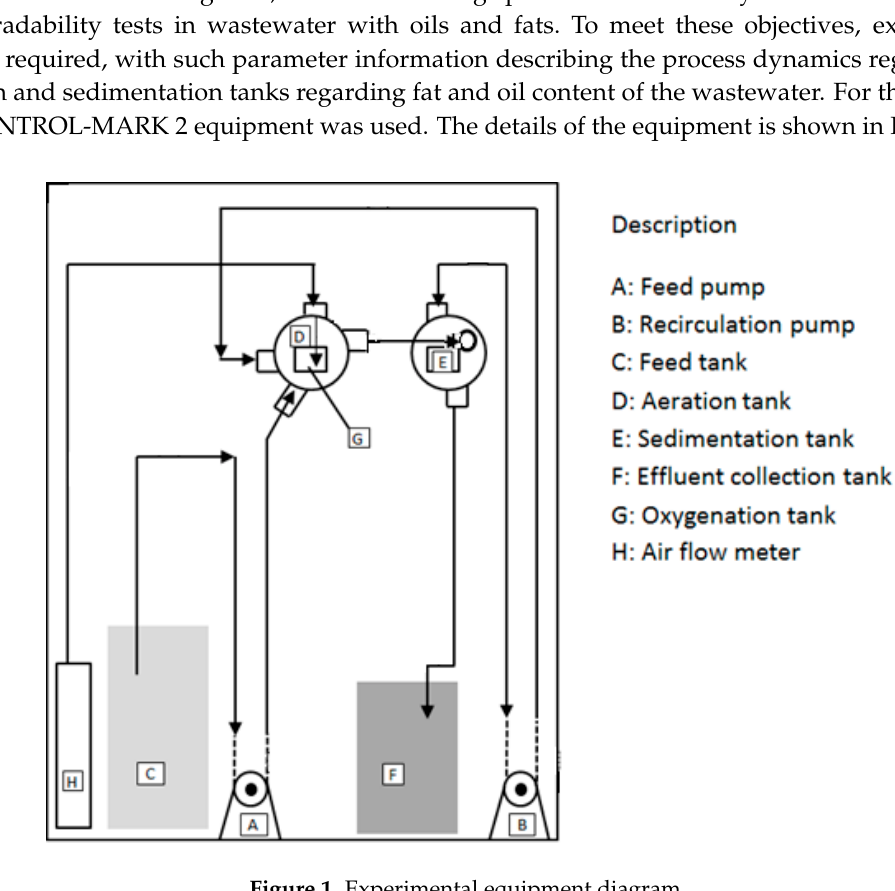
Figure 1. Experimental equipment diagram.